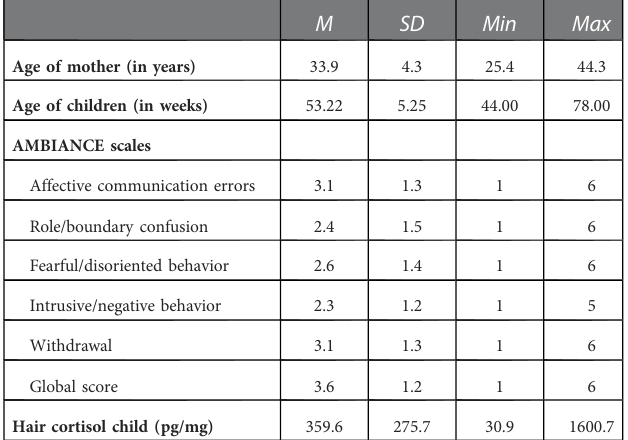
TABLE 1 Descriptive statistics of AMBIANCE subscales, AMBIANCE global score, and child ’ s hair cortisol for N =111 mother-child-dyads.